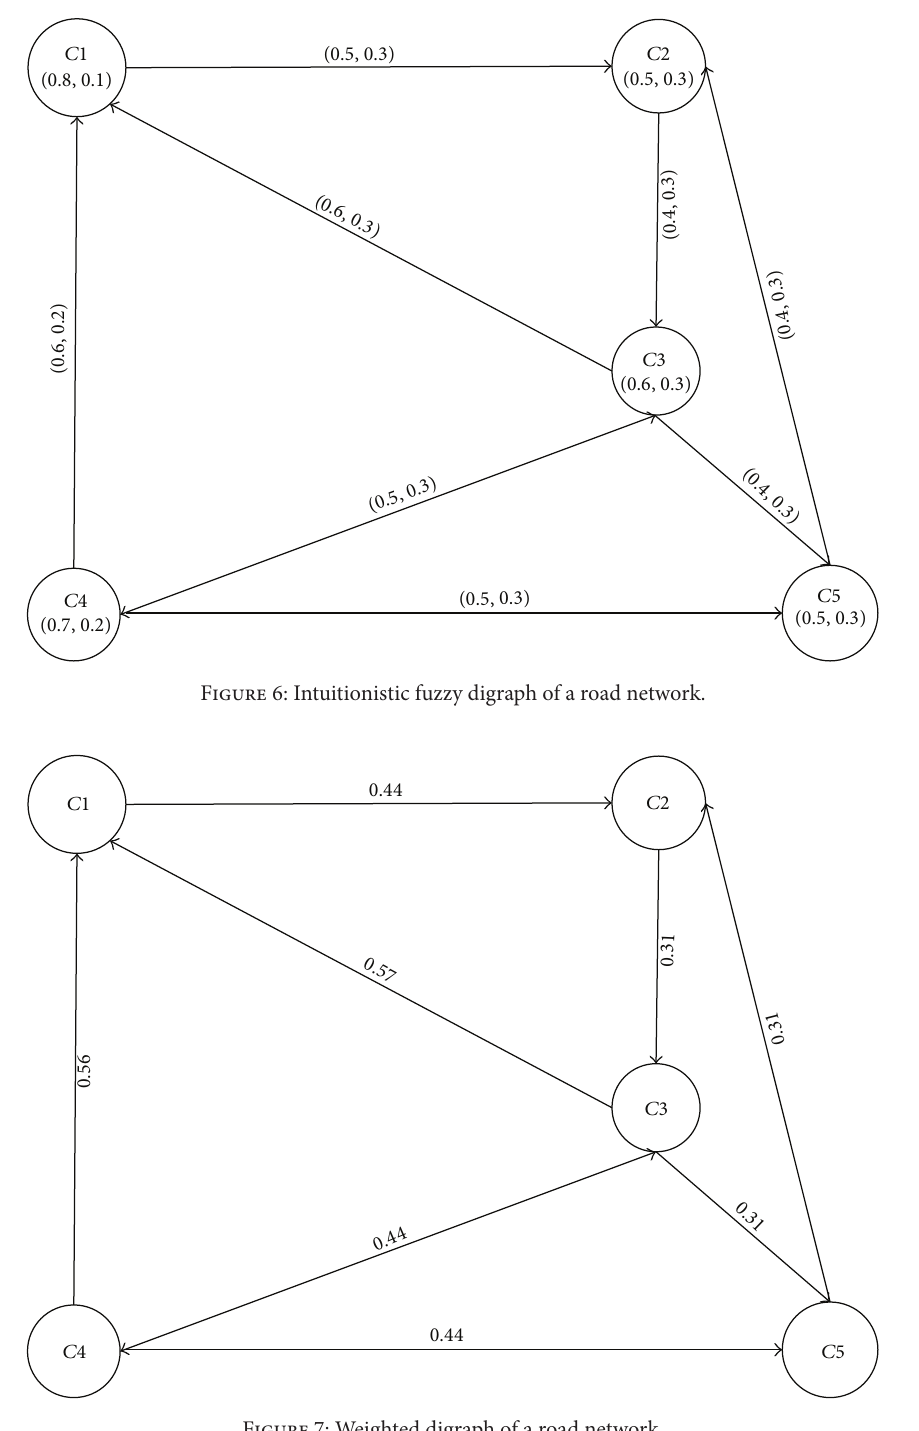
Figure 7: Weighted digraph of a road